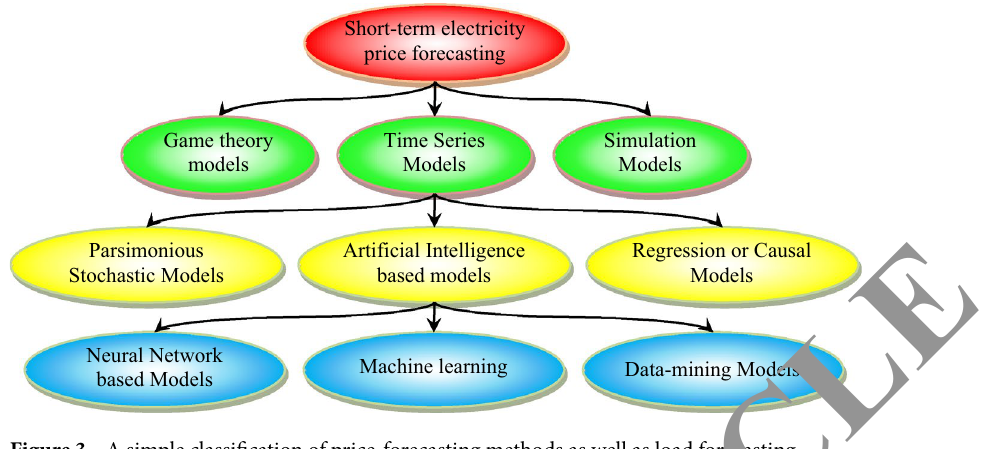
Figure 3. A simple classification of price-forecasting methods as well as load